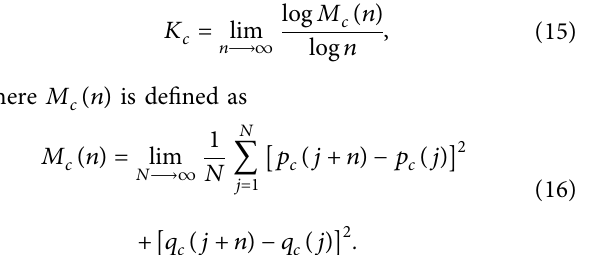
Figure 1: Probable phase plots of the dynamical system (12) for κ � 5, n σ p � 0 . 2, V bo � 17 . 14, μ pb � 1836, and μ pi � 0 . 25187 with (a) V � 1 . 1, (b) V � 1 . 225, (c) V � 1 . 24, and (d) V � 1 .